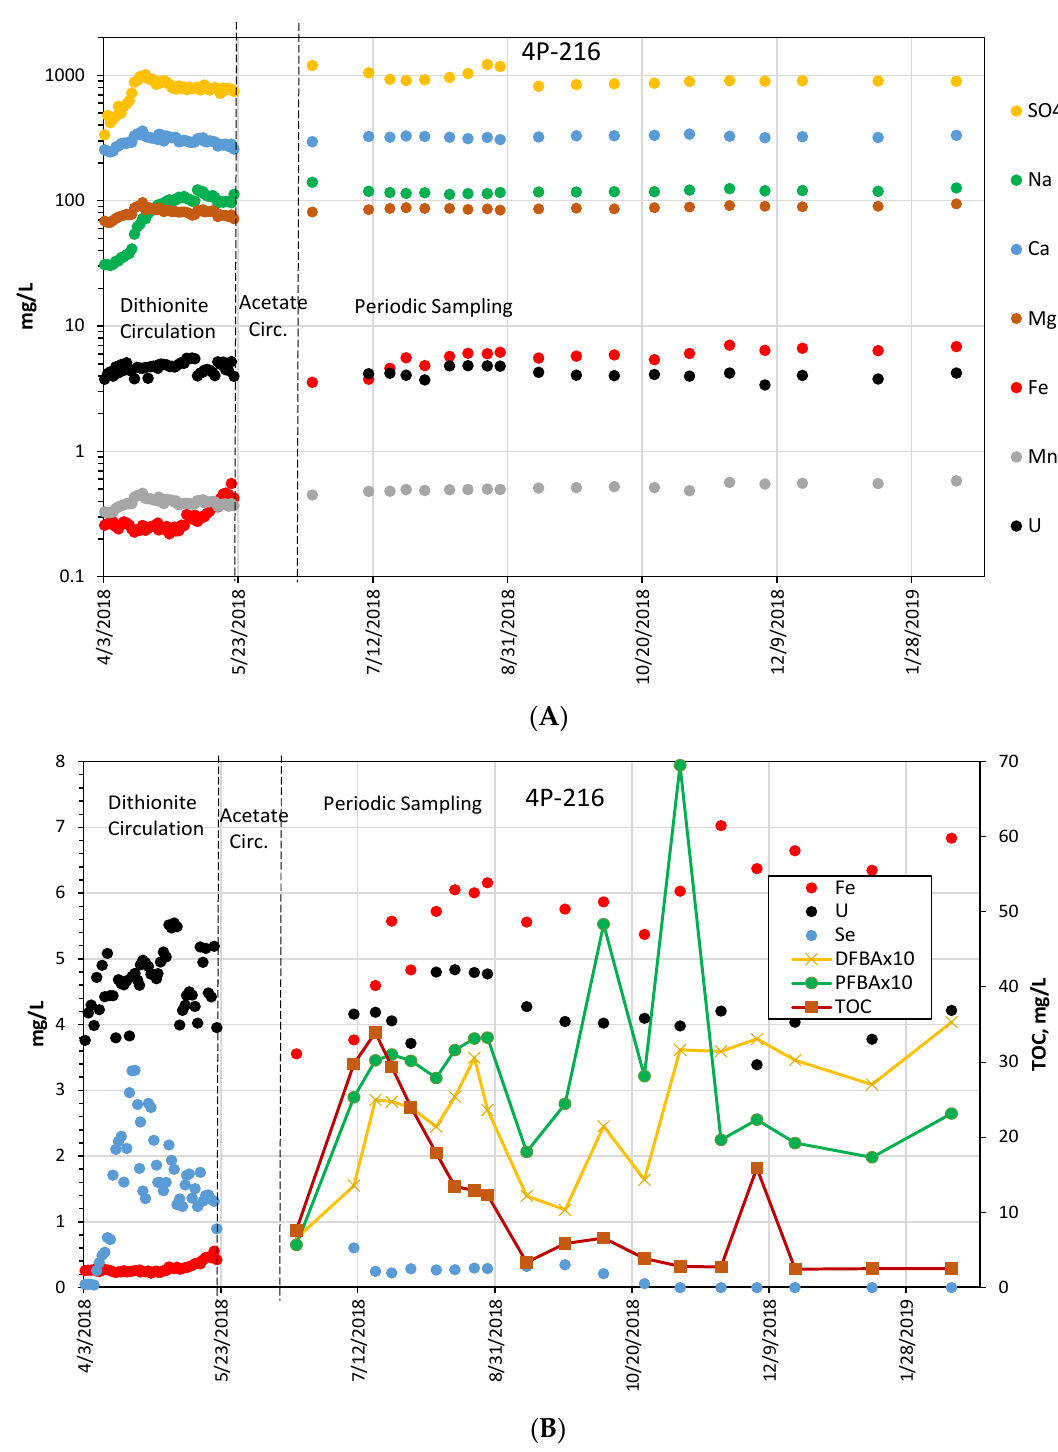
Figure A24. ( A ) Concentration histories of several key constituents in production well 4P-216 during the amendment test. ( B ) Concentration histories of redox-sensitive constituents (Fe(II), U, Se), TOC (as acetate surrogate), and tracers. Note that difluorobenzoate (DFBA) and pentafluorobenzoate (PFBA) concentrations are multiplied by 10.